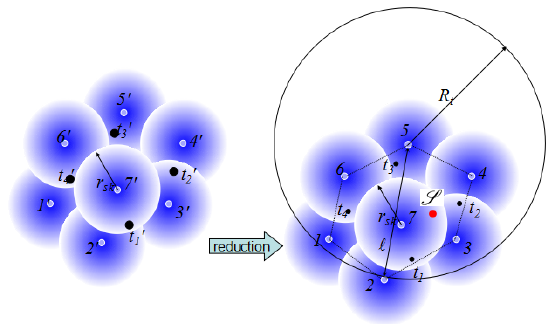
Figure 4. A reduction from the minimum (cid:101) -detection coverage problem to the minimum (cid:101) -CTC problem. Indeed, each sensor after the reduction has a communication radius. For simplicity, we draw only one sensor with the communication